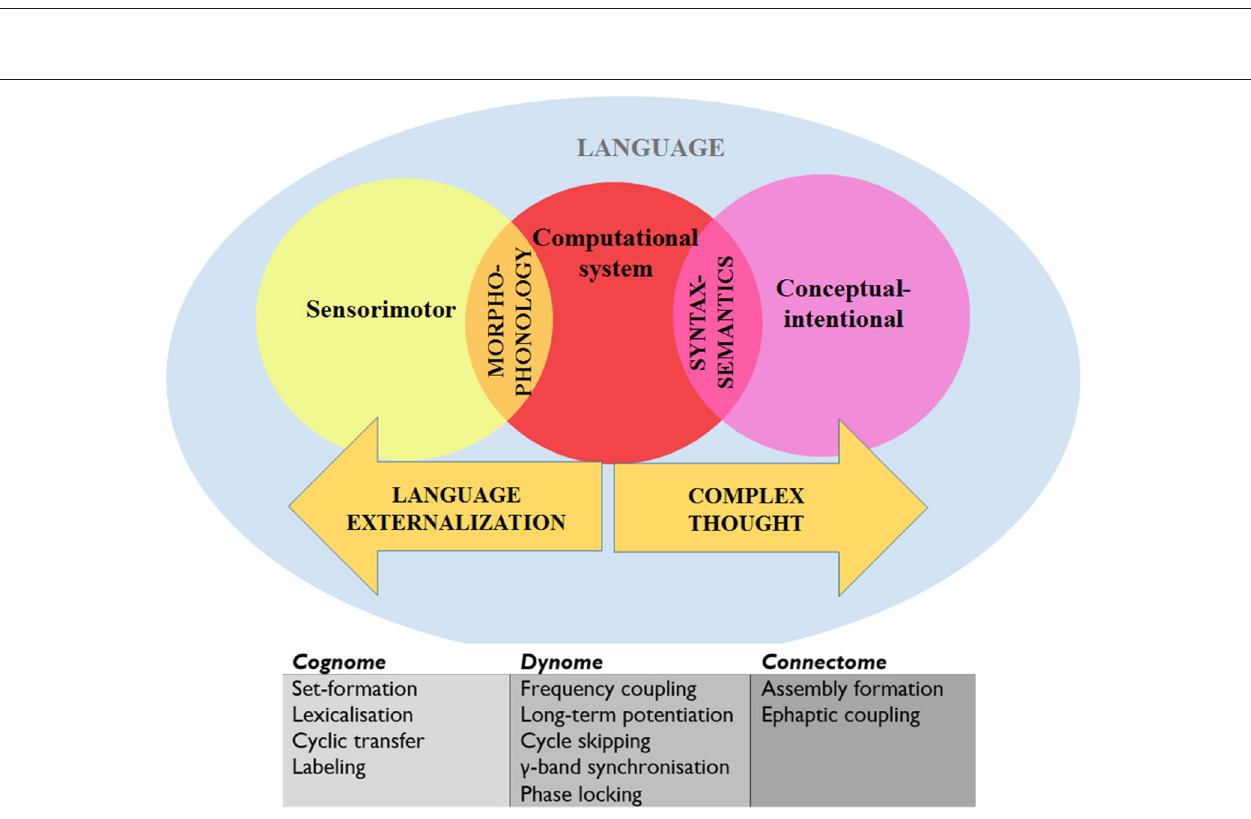
FIGURE 4 | Expression profiles of candidates genes in the cerebellum of children and adults with ASD. Expression data were obtained from the microarray expression dataset GSE38322 (Ginsberg et al., 2012) available on the Gene Expression Omnibus database (GEO datasets, http://www.ncbi.nlm.nih.gov/gds). Data are shown as log transformation of fold changes (logFC) between patients and corresponding controls. Only genes showing statistically significant ( p < 0.05) differential expression were considered. Additional details may be found in the Supplemental information file.